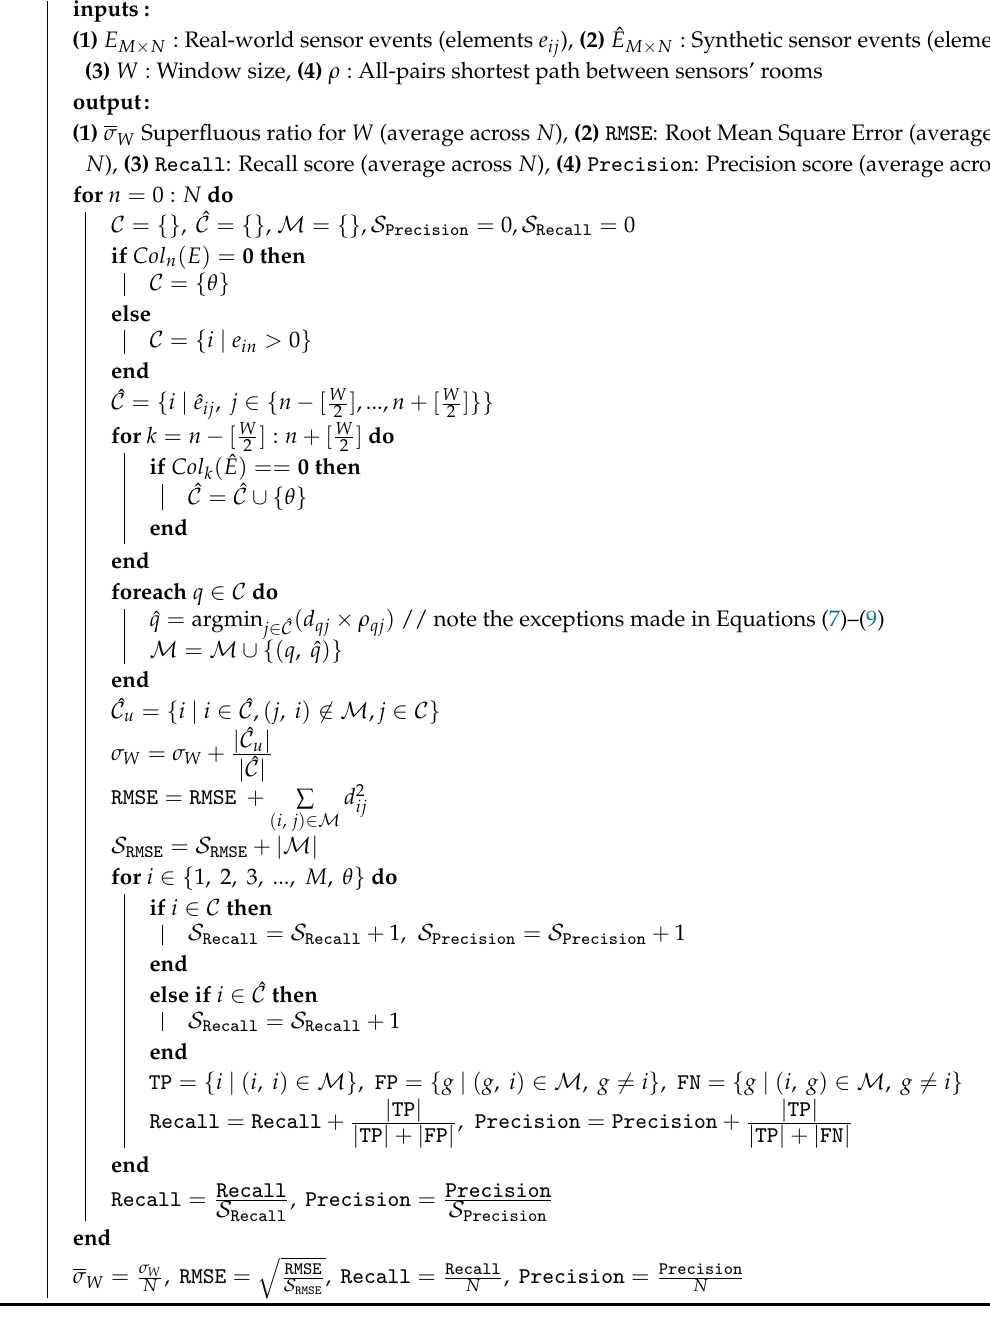
Algorithm 1: Finds a matching list for real-world sensor activation sequence (SAS) regarding window size and calculates